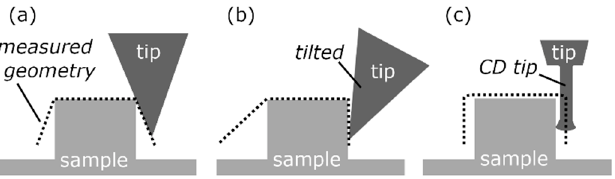
Figure 1. Measured (apparent) geometries without tip-deconvolution (dotted line) of the conventional atomic force microscope (AFM) ( a ), the tilting AFM ( b ), and the two-dimensional (2D)/critical dimension (CD) AFM ( c ) with the specialized cantilever with a CD tip.